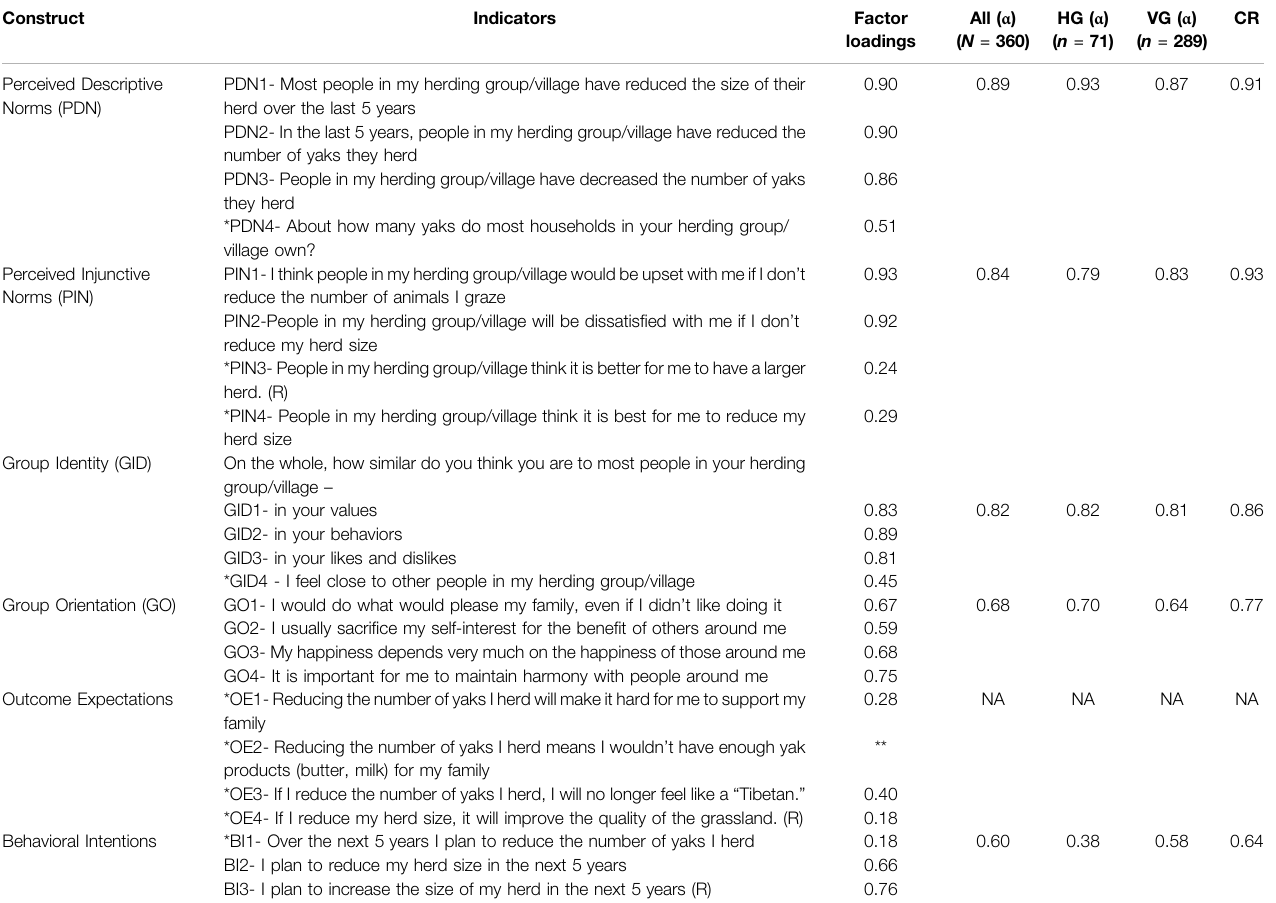
TABLE 1 | The Measurement Model of the Six Constructs. Construct